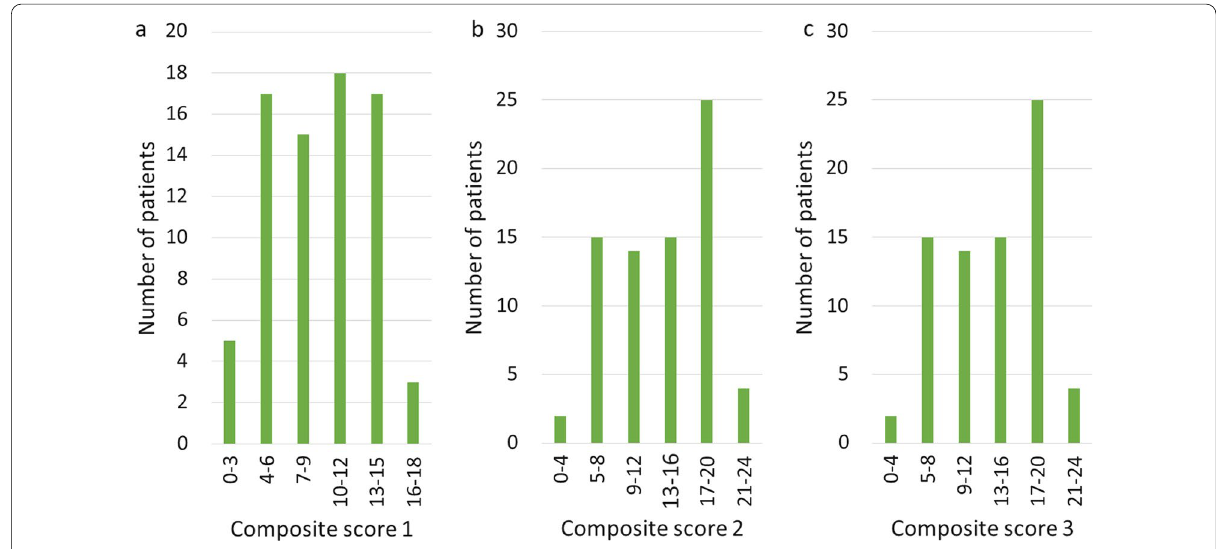
Fig. 1 Distribution of composite scores in survey sample ( n